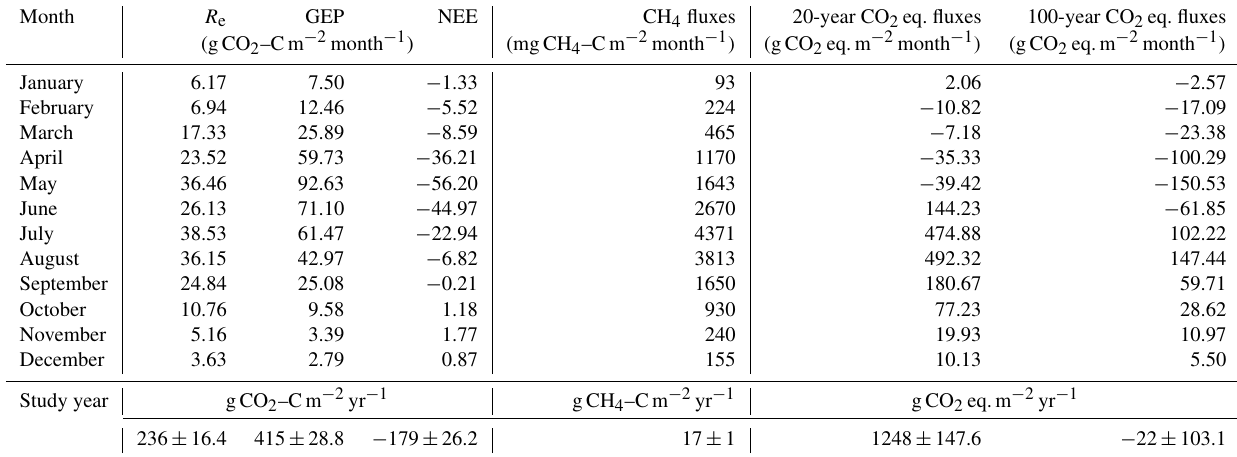
Table 1. Monthly EC-measured and gap-filled NEE (CO 2 fluxes), CH 4 fluxes, CO 2 eq. fluxes using 20-year GWP, and CO 2 eq. fluxes using 100-year GWP at the study site during the study